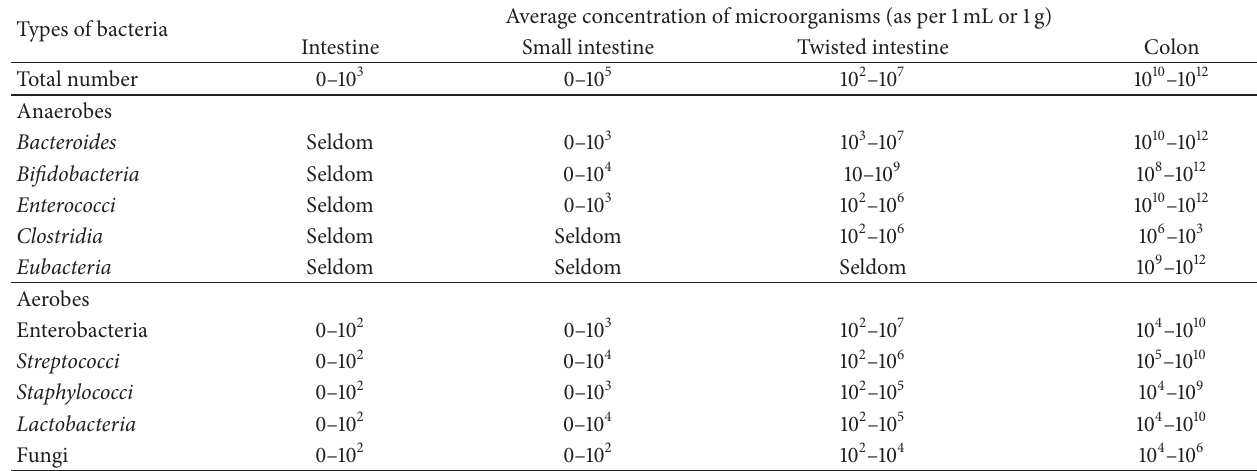
Table 2: Composition of the intestinal organisms of the human [19].